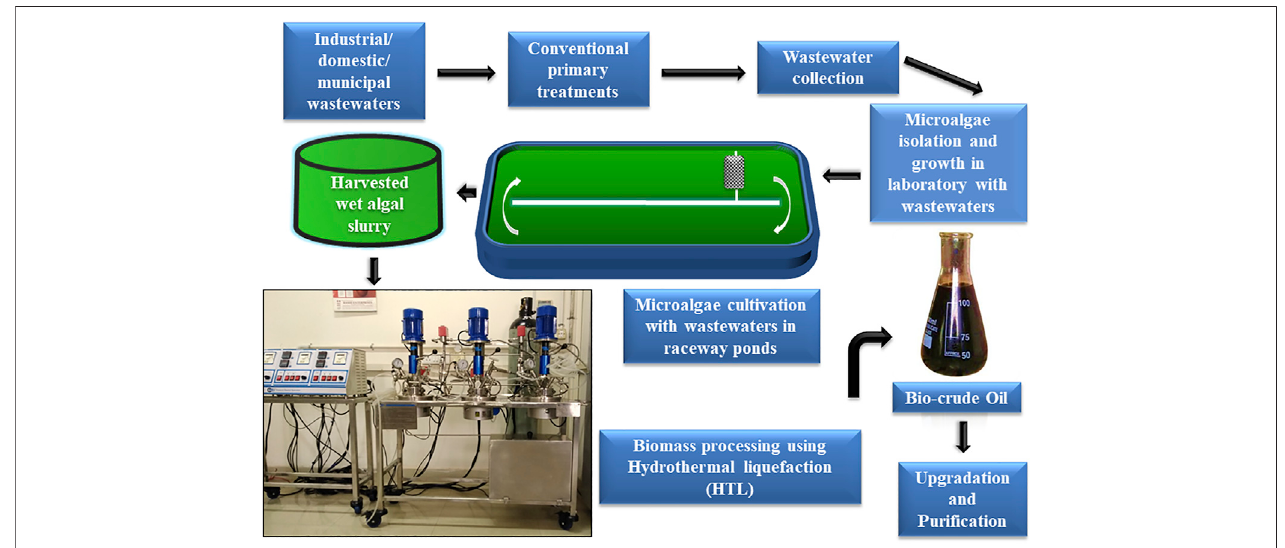
FIGURE 2 | Diagrammatic representation of microalgal cultivation in large-scale raceway ponds with wastewaters coupled with bio-crude oil production using wet algal biomass hydrothermal processing.